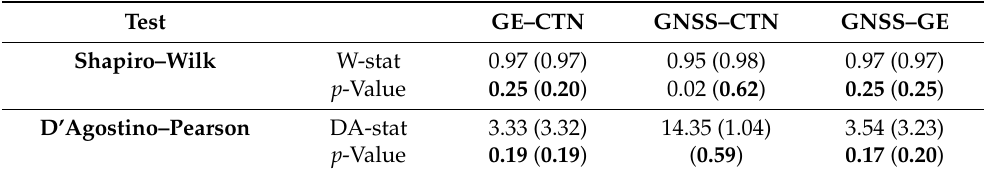
Table 7. Shapiro–Wilk and D’Agostino–Pearson tests of the pairs ∆ h : p -values < 0.02 are omitted, while the resulting univariate normal distributions are highlighted in